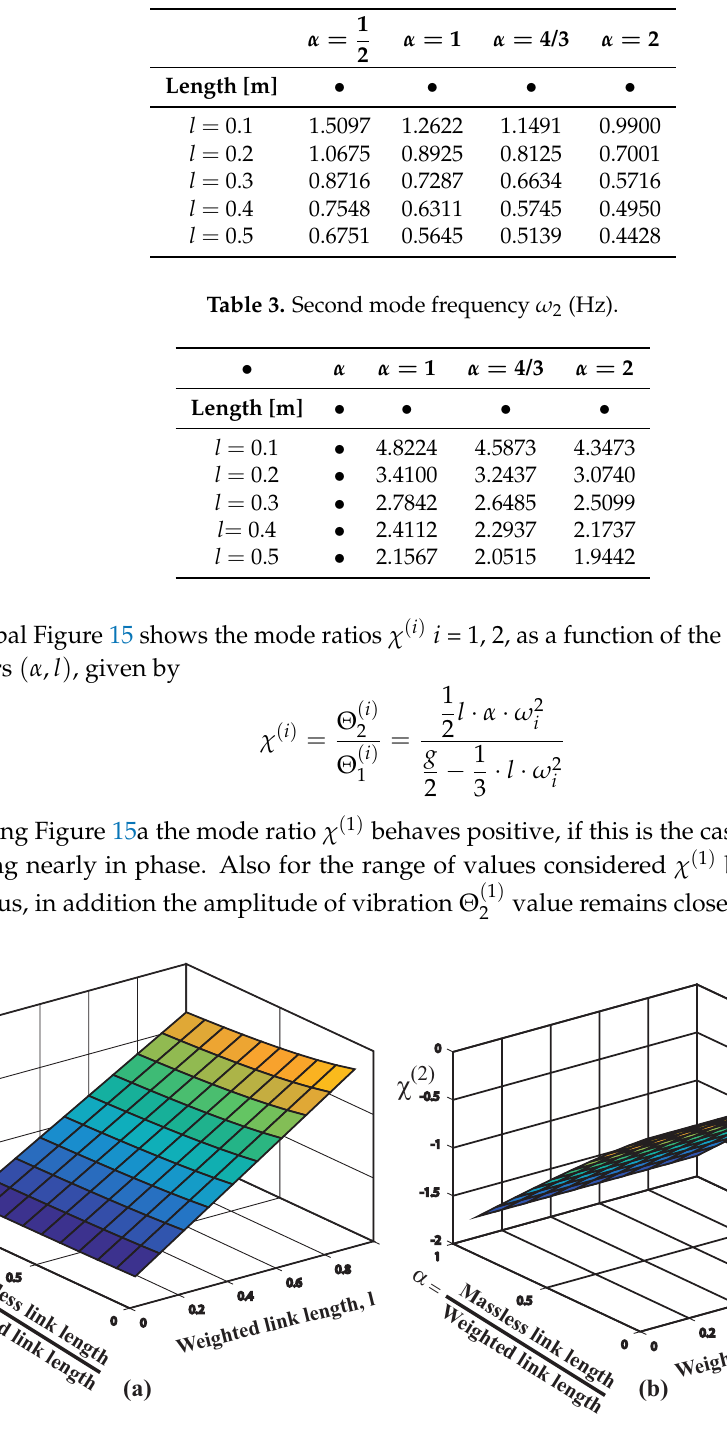
Figure 15. Mode ratio results: first mode 1.5 ≥ χ ( 1 ) > 0 both links swing in nearly in phase; second mode 0 > χ ( 2 ) > − 2 both links swing in opposite phases. Conditions: l ≤ 1 m, 0 < α ≤